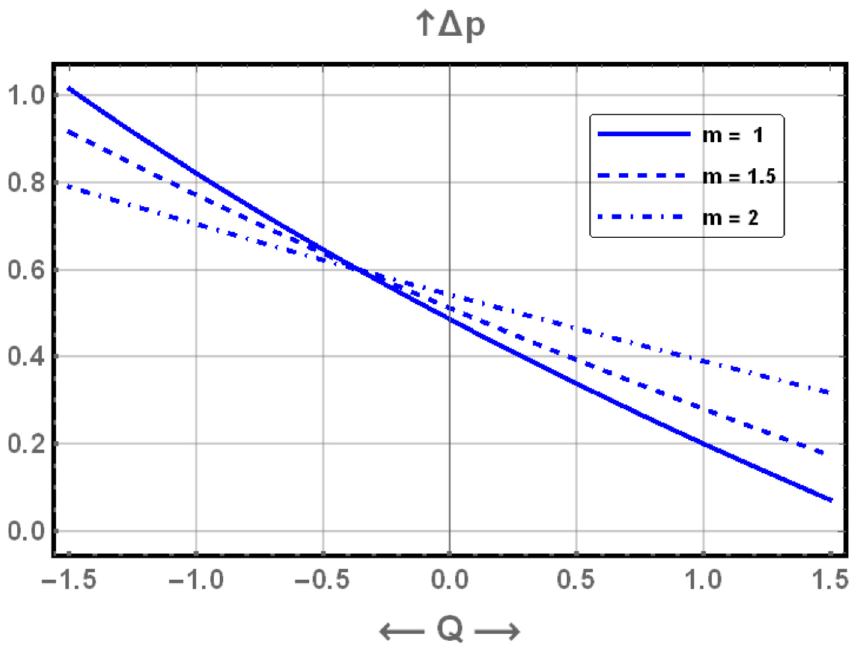
Figure 26. Display of pressure rise vs. volume flow rate for different values of m .